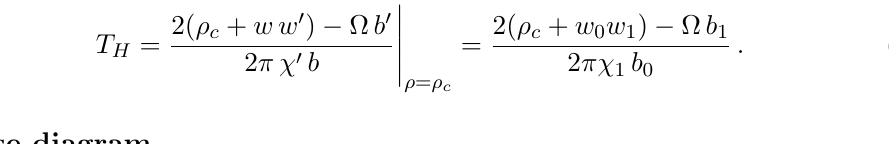
Figure 2 . Electric (cid:12)eld of the critical embeddings versus driving frequency. The frequencies for which E vanish are the critical frequencies (cid:10) c of the vector meson Floquet condensates. The blue dots signal the frequencies (4.1) of the vector meson spectrum for di(cid:11)erent values of the principal quantum number n . On the right hand side, the three dimensional version of the left plot, focussing close to the (cid:12)rst critical point, which stretches into a segment (cid:10) =m 2 (1 : 496 ; 1 : 732). Using the values of (cid:13) and (cid:13) found above, we get the T in terms of near horizon tt t(cid:26) H